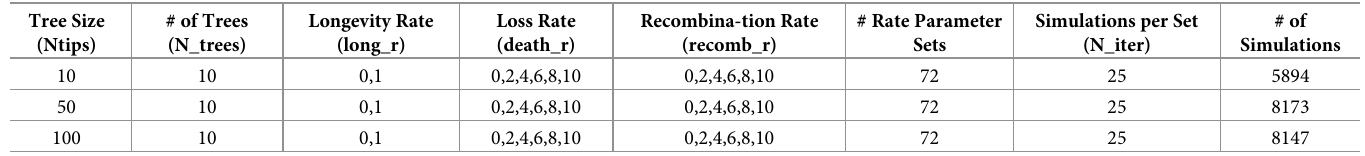
Table 2. Gene family evolutionary history simulations: Parameters used. Tree Size # of Trees (Ntips)